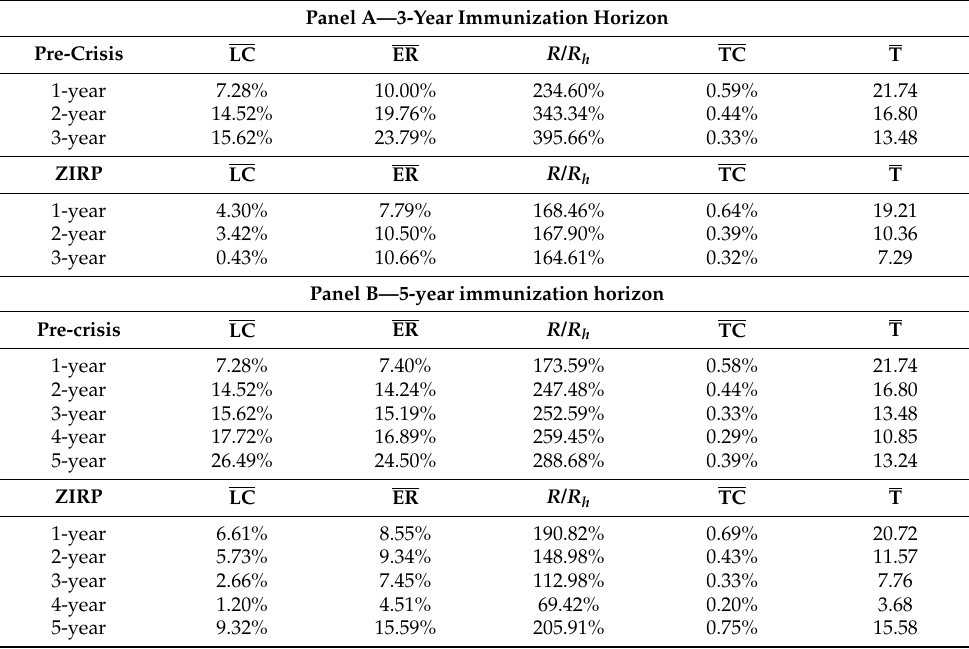
Table 5. U.S. TIPS with Inflation Accrual Sensitivity Analysis Immunization